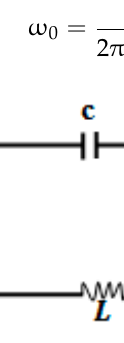
Figure 1. Equivalent circuit model of the SRR. C is the intrinsic capacitance. L is the intrinsic inductance. R is the intrinsic resistance which introduces the system loss.